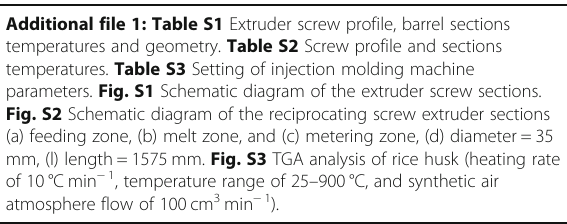
Fig. S2 Schematic diagram of the reciprocating screw extruder sections (a) feeding zone, (b) melt zone, and (c) metering zone, (d) diameter = 35 mm, (l) length= 1575 mm. Fig. S3 TGA analysis of rice husk (heating rate of 10°C min − 1 , temperature range of 25 – 900 °C, and synthetic air atmosphere flow of 100 cm 3 min − 1